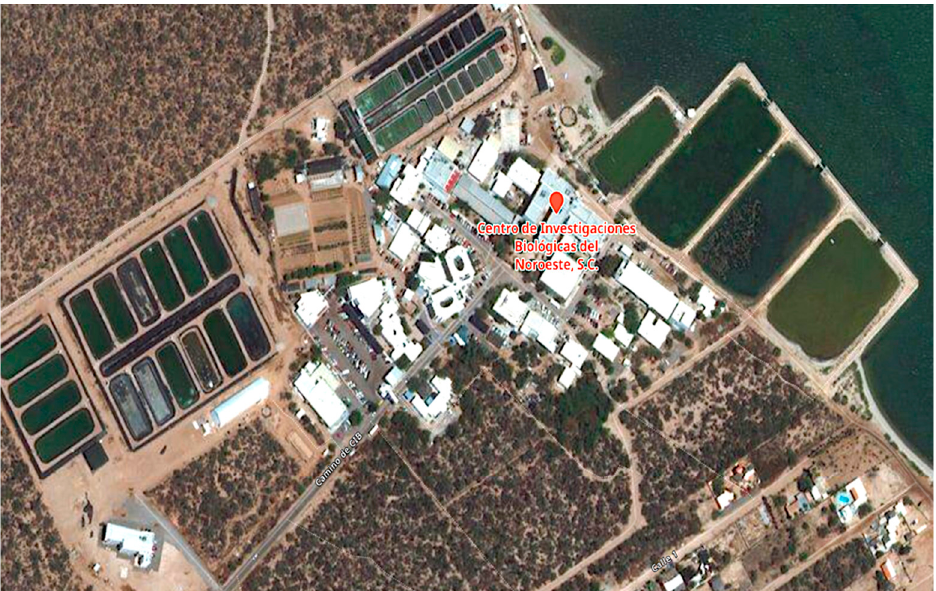
Figure 1. Geographical location of the Center for Biological Research of Northwest México S.C. (CIBNOR), west La Paz City, México. (Google Earth).